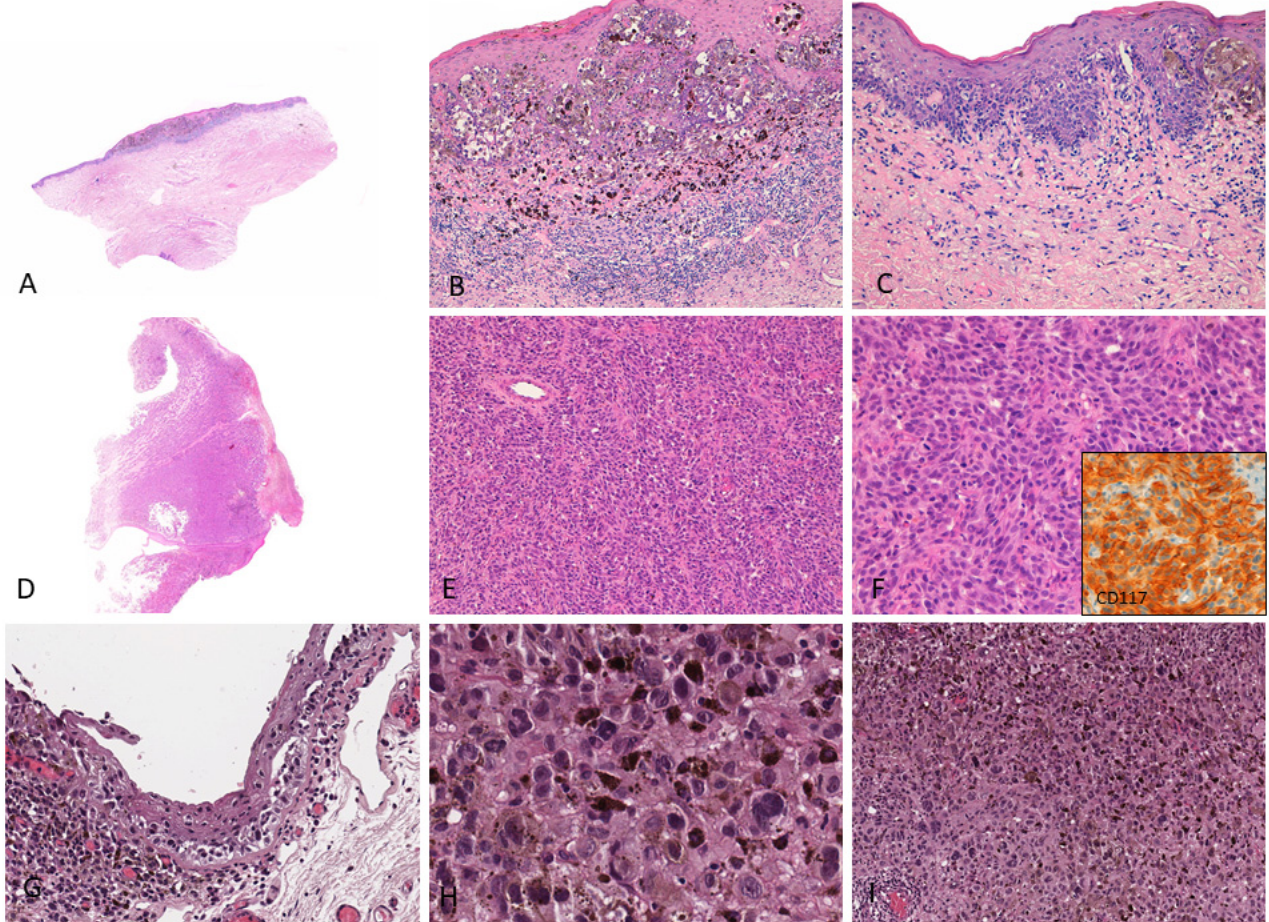
Figure 1. ( A – C ) Female, 76 years–Mucosal melanoma on the vulva (labia minora) characterized by atypical pigmented melanocytes in single units and nests with pagetoid spread; a brisk lymphocytic infiltrate with numerous melanophages is observed in the upper dermis; ( D – F ) Male, 86 years– Endoscopic biopsy reveals a bulky tumor diagnosed as amelanotic mucosal melanoma of the anal canal; the tumor shows diffuse proliferation of non ‐ pigmented epithelioid cells; tumor cells show cytoplasmic and membranous CD117 staining (inset); ( G – I ) Female, 47 years–Highly pigmented conjunctival mucosal melanoma (left eye) with prominent melanin pigment in intracellular and extracellular location; both in situ ( G ) and invasive components ( H , I ) are shown. These images come from the pathology archive of patients with mucosal melanomas, as indicated in the “Materials and methods” section.